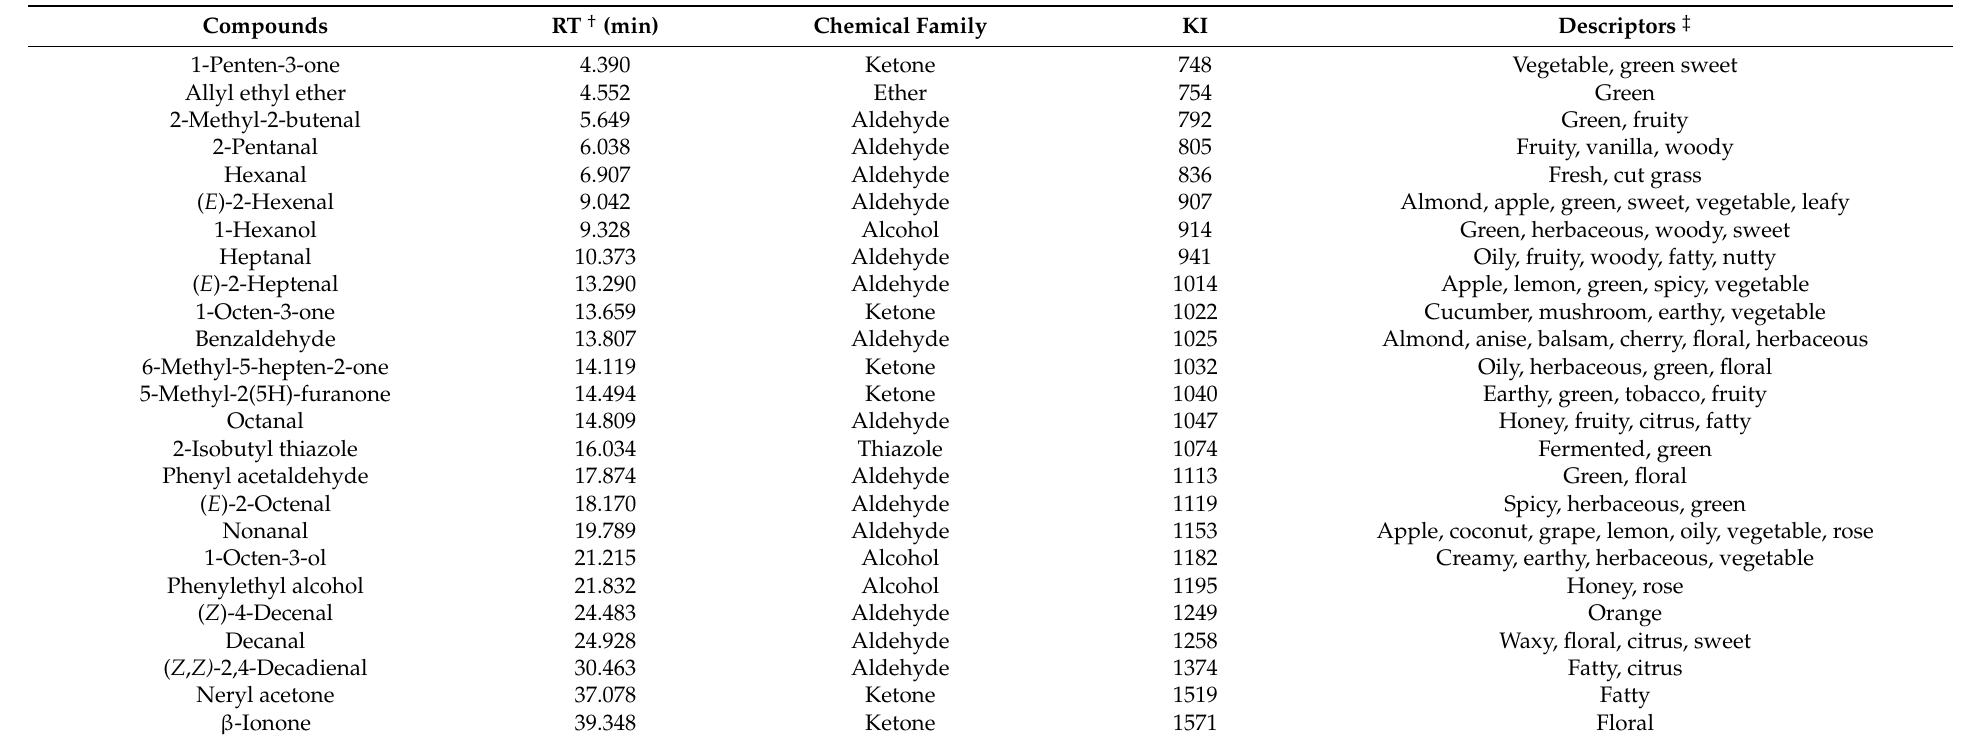
Table 2. Volatile compounds, retention index, and descriptors in cherry tomatoes as affected by cultivar for pear and round fruits.